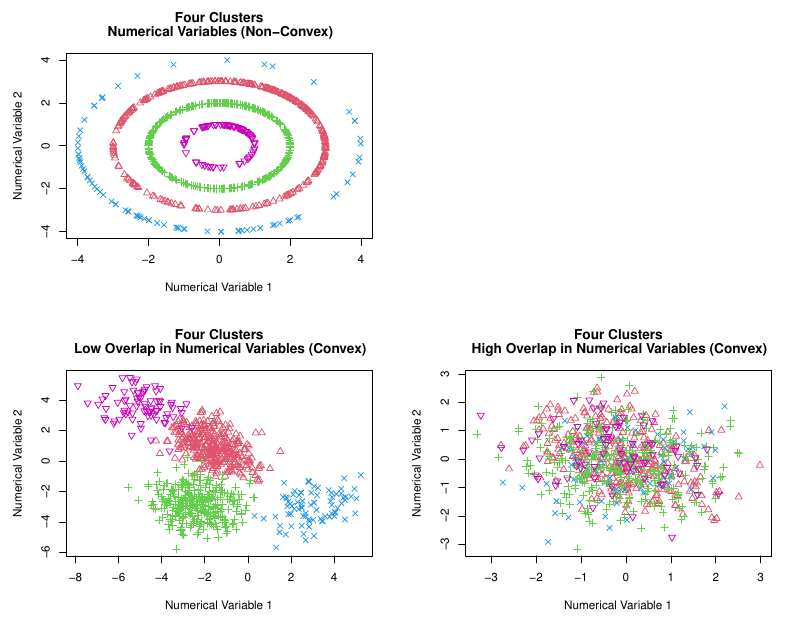
Figure 3. Example of continuous variables for the three scenarios with four clusters